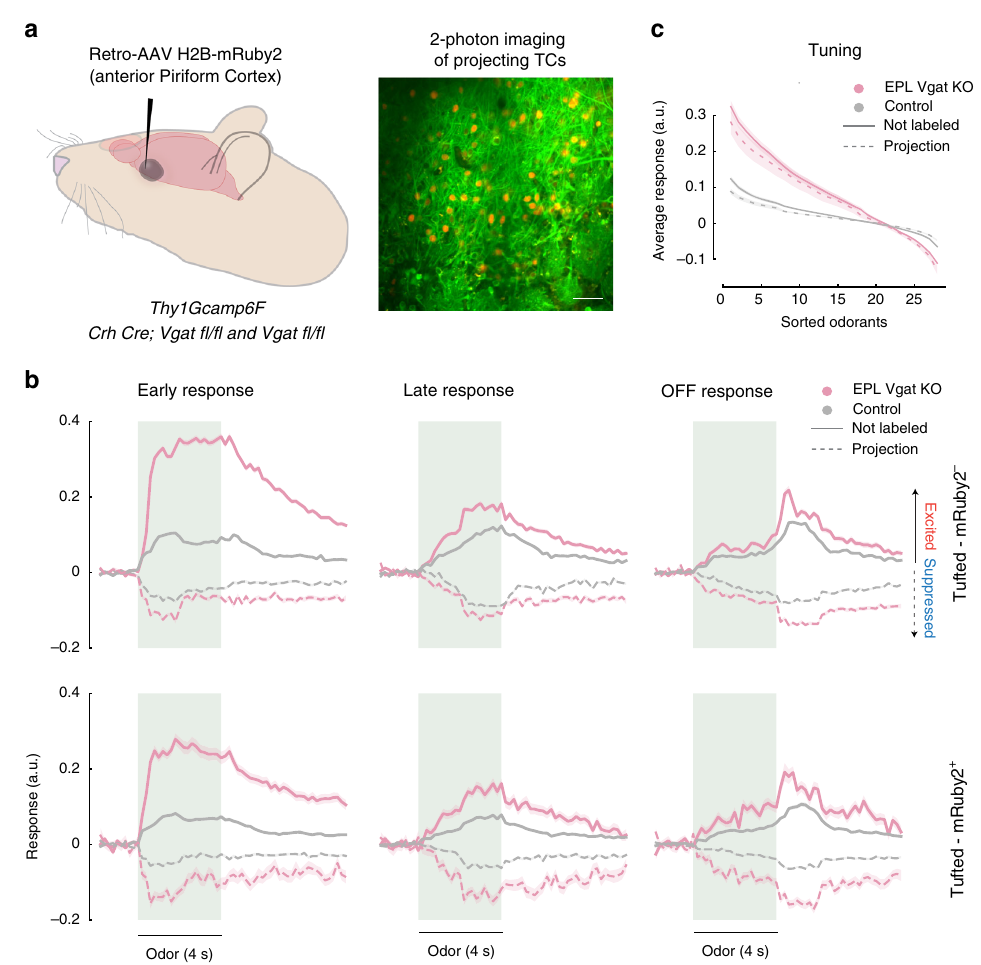
Fig. 6 Projecting TC and general TC responses are similarly affected without EPL-IN. a Experimental setup of Retro-AAV H2B-mRuby2 viral injection into the anterior piriform cortex (left) and subsequent 2-photon imaging 2 weeks following injection (right). b Calcium responses to odors across all signi fi cant cell-odor pairs for excited (uniform line) and suppressed (dotted line) units between EPL Vgat KO and control animals. Responses divided into Early ( fi rst 2s of odor), Late (last 2s of odor), and Off (2s after odor is turned off). mRuby2 negative TC (top) and mRuby2 positive TC (bottom). The number of